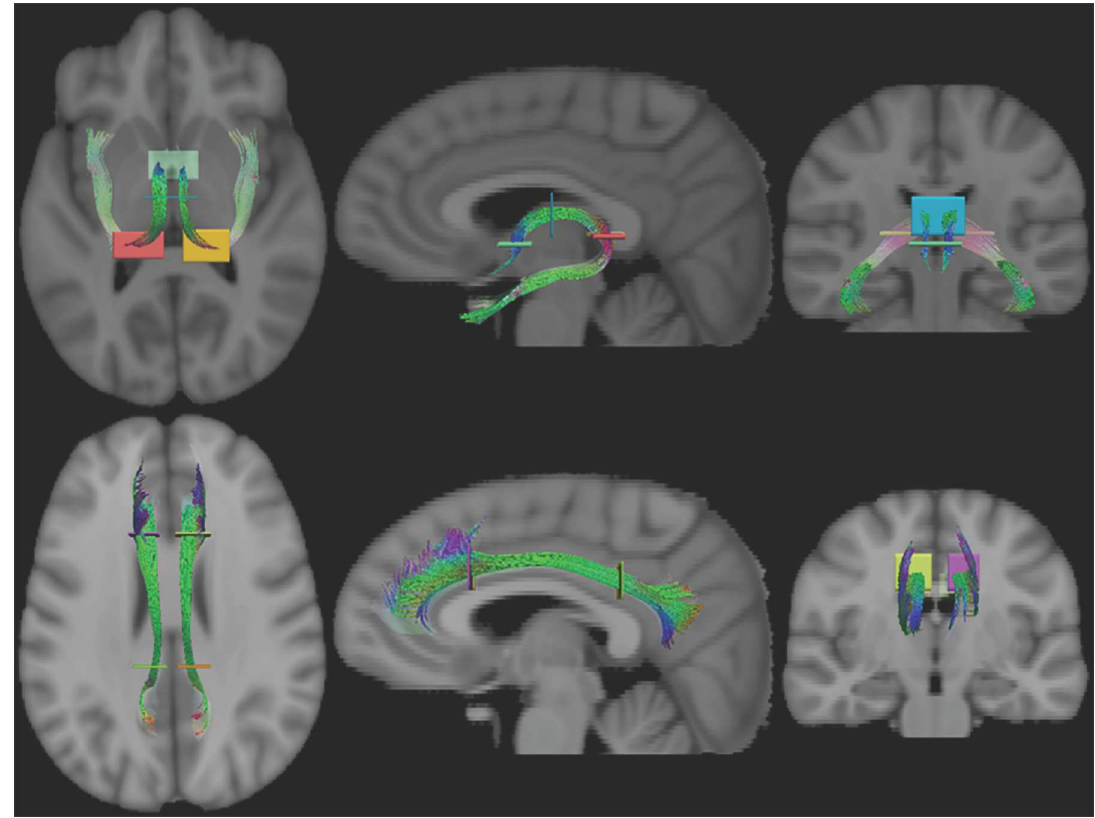
Fig 2. The ROIs used to define the fornix (top row) and superior cingulum (bottom row) in template space. Fornix tracts were reconstructed if they passed through the columns(green), body (blue) and either the right crux (red) or left crux (yellow).Cingulumtracts were reconstructed if they passed through an anterior ROI (left: yellow, right: purple) and a posterior ROI (left: orange, right: green).